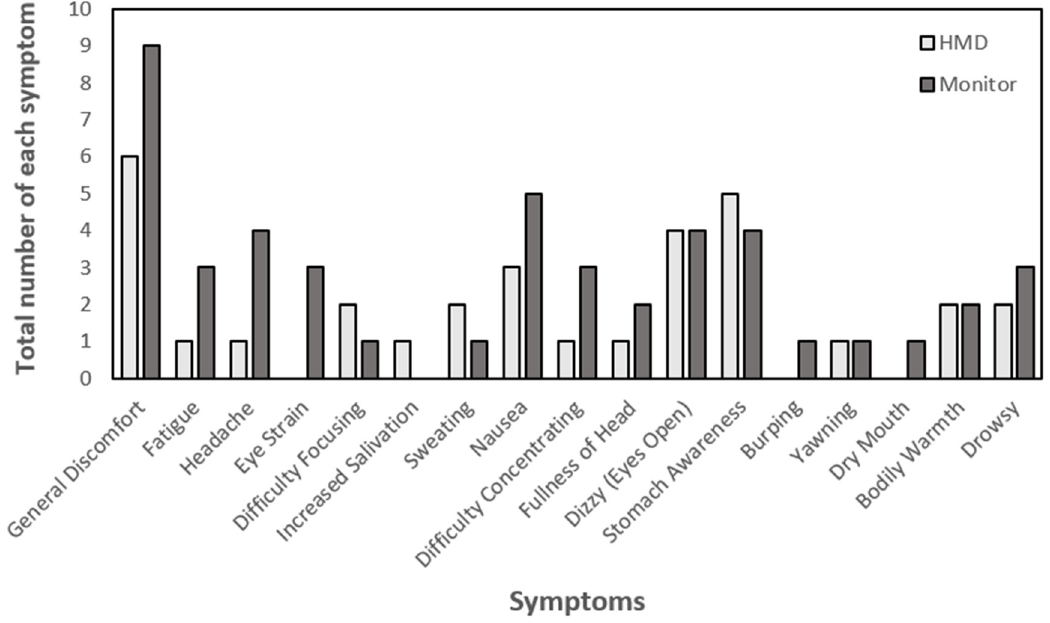
Figure 4. The total number of each symptom reported by subjects after the exposure to motion with the two visual